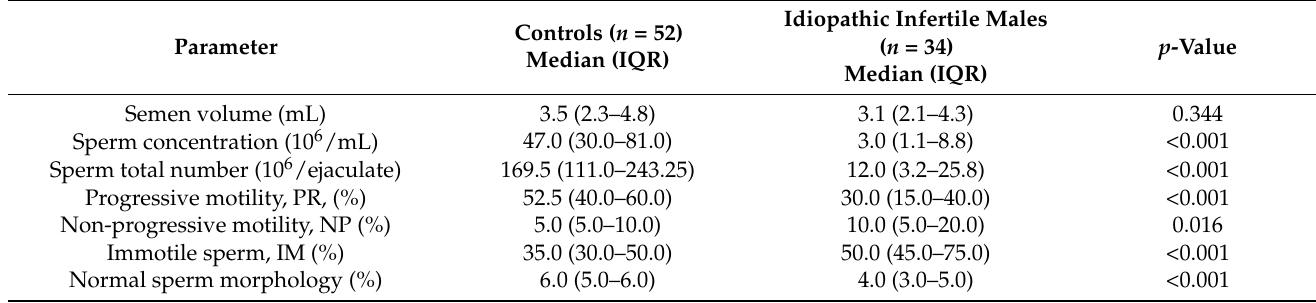
Semen parameters of 34 idiopathic infertile men and 52 age-matched normo- zoospermic